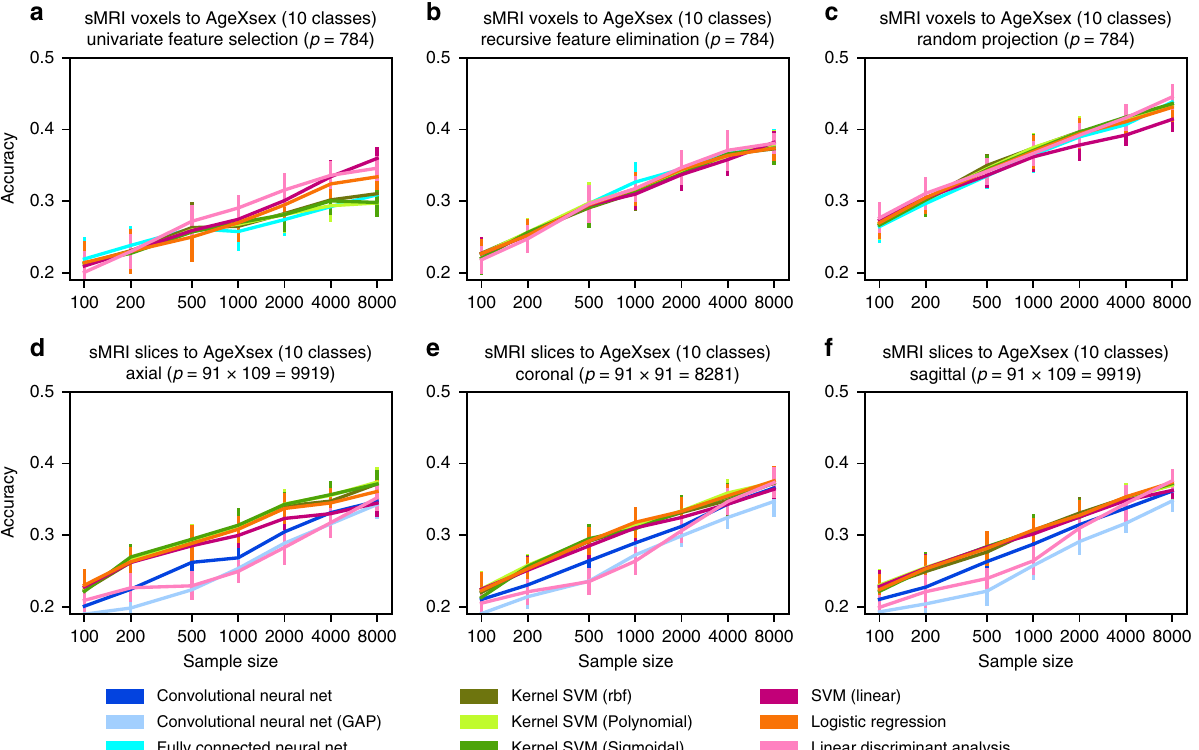
Fig. 3 Powerful predictive algorithms fail to improve classi fi cation accuracy for several views on brain images. a – c Whole-brain gray matter information from structural brain images (sMRI, UKBiobank) was summarized by three widely used feature selection/engineering techniques. The original tens of thousands of gray matter voxel volumes were reduced to 784 variables for comparability to the dimensionality of MNIST and Fashion (Fig. 1), as a basis for learning predictive patterns for classifying ten sex/age groups. Prediction accuracies achieved using univariate feature selection (relevance tests independent for each variable) are outperformed by recursive feature elimination (accounting for conditional effects between variables), which in turn is superseded by random projections (low-rank transformations of all original variables). None of these dimensionality-reduced brain images lead to systematic differences between linear (red tones), kernel (green tones), and deep (blue tones) model classes. In particular, fully connected deep neural networks did not visibly outperform the examined classical linear or kernel methods. d – f Axial, coronal, and sagittal slices of whole-brain gray matter images (sMRI) were used for a ten-group categorization. In contrast to classifying 2D images of digits and clothing into ten categories (Fig. 2a, c), classifying 2D images of brain anatomy into ten age/sex groups does not exhibit obvious performance differences between linear, kernel, and deep models. These analyses again indicate scarcity of easily exploitable nonlinear structure in common sMRI brain scans for the present sample sizes. The number of input variables in a modeling scenario is denoted by p . Error bars = mean ± 1 SD across 20 cross-validation iterations (all